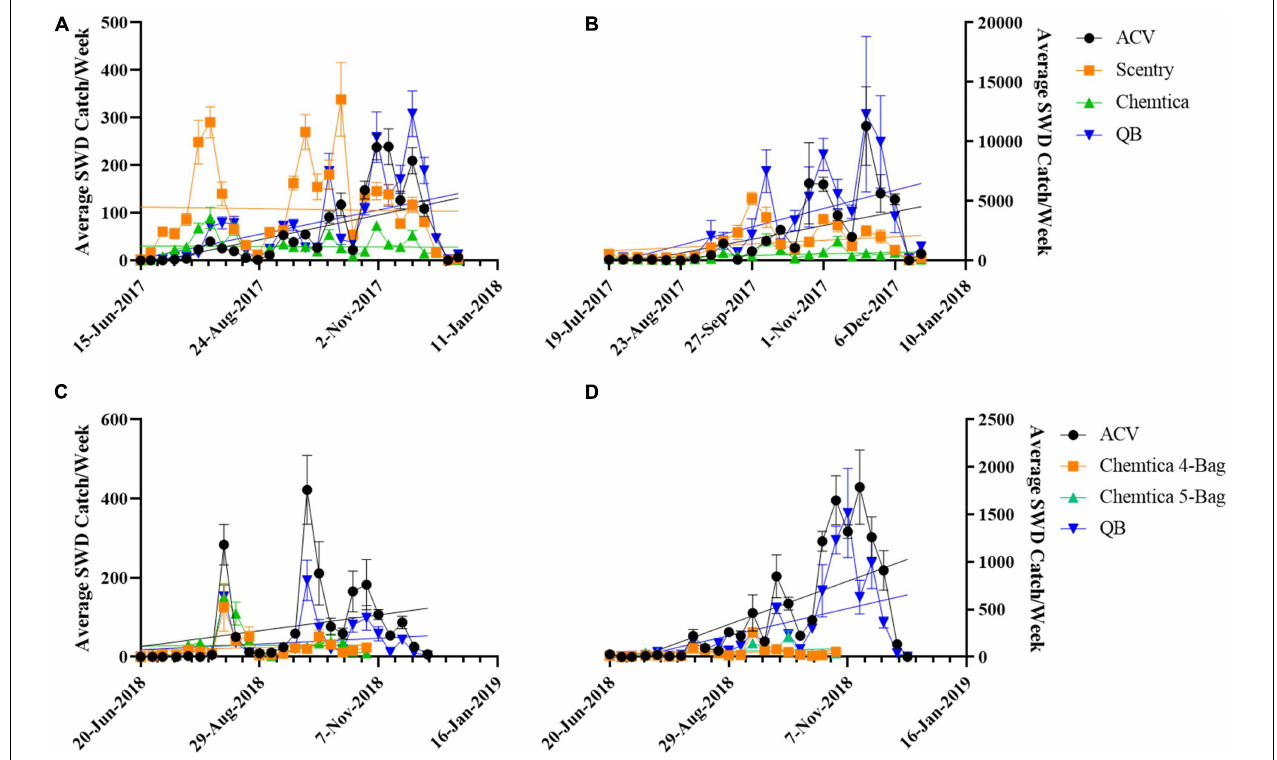
FIGURE 3 | Average capture of SWD per week over the entire 2017 and 2018 trapping periods. (A) Blueberry field in Maryland 2017 [apple cider vinegar (ACV): Y = 5.228X–8.541, R 2 = 0.2404, Deviation from 0 significant P < 0.0001; Scentry: Y = -0.3306X + 112.2, R 2 = 0.0005, Deviation from 0 not significant P = 0.6821; ChemTica: Y = –0.0912X + 30.42, R 2 = 0.0004, Deviation from 0 not significant P = 0.6988; and quinary blend (QB): Y = 5.112X + 3.995, R 2 = 0.1606, Deviation from 0 significant P < 0.0001]; (B) Wooded area near a blueberry field in Maryland 2017 (ACV: Y = 231.9X–536.3, R 2 = 0.2085, Deviation from 0 significant P < 0.0001; Scentry: Y = 59.73X + 804.2, R 2 = 0.0636, Deviation from 0 significant P = 0.003; ChemTica: Y = 25.36X + 178.3, R 2 = 0.0791, Deviation from 0 significant P = 0.001; and QB: Y = 308.1X–251.7, R 2 = 0.1394, Deviation from 0 significant P < 0.0001); (C) Blueberry field in Maryland 2018 (ACV: Y = 4.011X + 26.16, R 2 = 0.0538, Deviation from 0 significant P = 0.0043; ChemTica 4-bag: Y = 0.6949X + 16.67, R 2 = 0.0079, Deviation from 0 not significant P = 0.3349; ChemTica 5-bag: Y = 0.1086X + 27.88, R 2 = 0.0002, Deviation from 0 not significant P = 0.8809; and QB: Y = 1.498X + 18.02, R 2 = 0.0315, Deviation from 0 significant P = 0.0299); and (D) Wooded area near a blueberry field in Maryland 2018 (ACV: Y = 45.61X–113.2, R 2 = 0.3058, Deviation from 0 significant P < 0.0001; ChemTica 4-bag: Y = 2.528X + 19.93, R 2 = 0.0467, Deviation from 0 significant P = 0.0178; ChemTica 5-bag: Y = 2.913X + 31.17, R 2 = 0.0542, Deviation from 0 significant P = 0.0105; and QB: Y = 28.7X–63.2, R 2 = 0.1917, Deviation from 0 significant P <